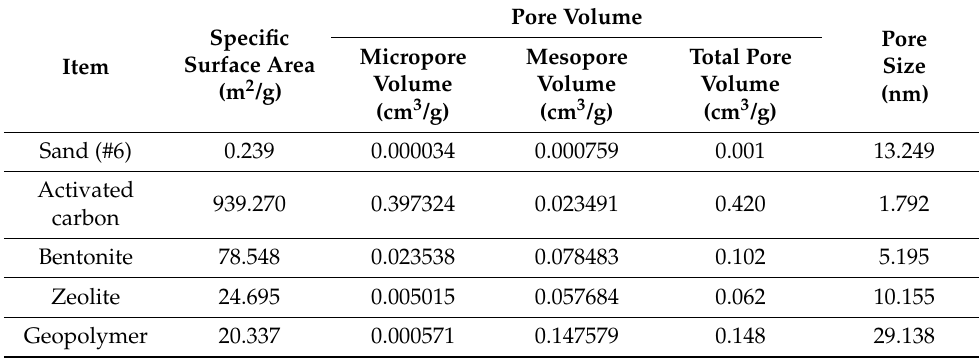
Table 2. Specific surface area, total pore volume, and average pore size of admixtures and